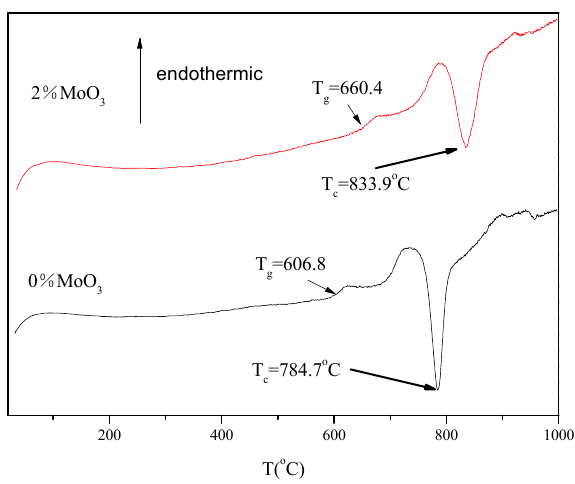
Figure 5. Differential scanning calorimetry (DSC) curves of samples during heating. Figure 5. Di ff erential scanning calorimetry (DSC) curves of samples during